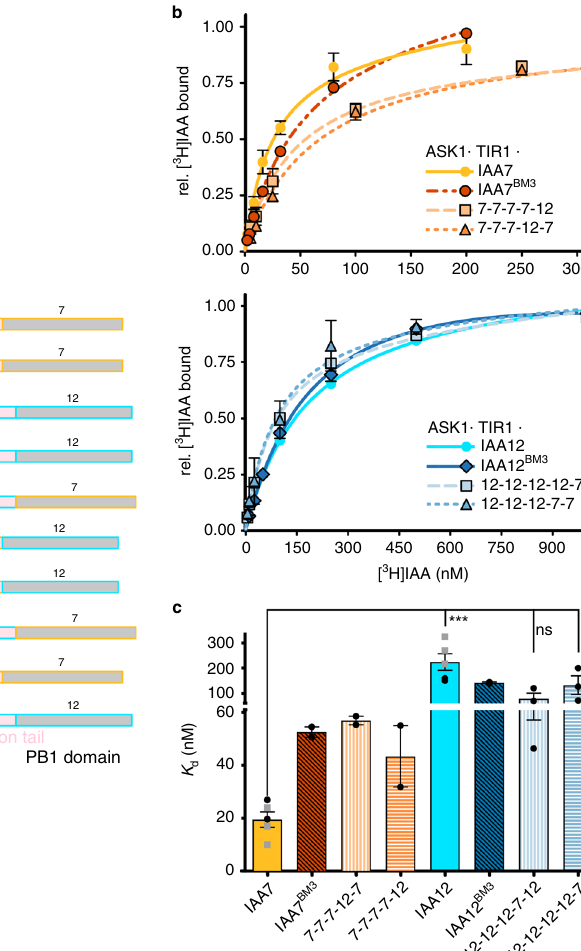
Fig. 6). The decrease in the auxin binding af fi nity of TIR1·IAA7 BM3 and TIR1·IAA (7-7-7-7-12) hints to a positive effect of the IAA7